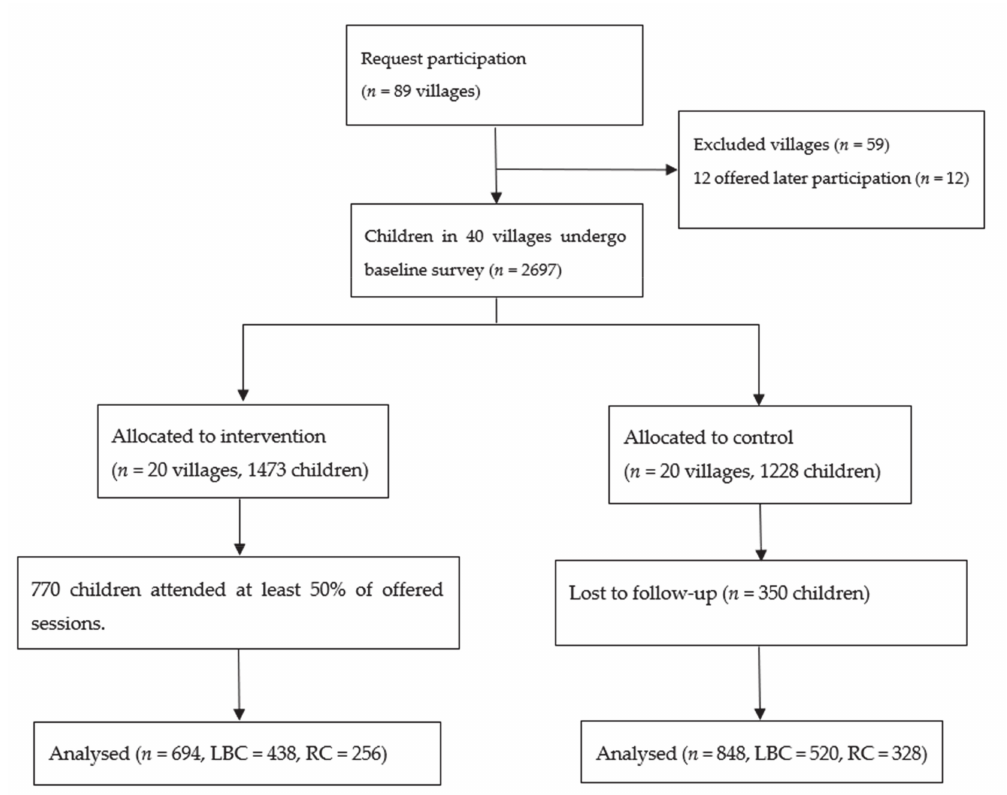
Figure 1. Study flow